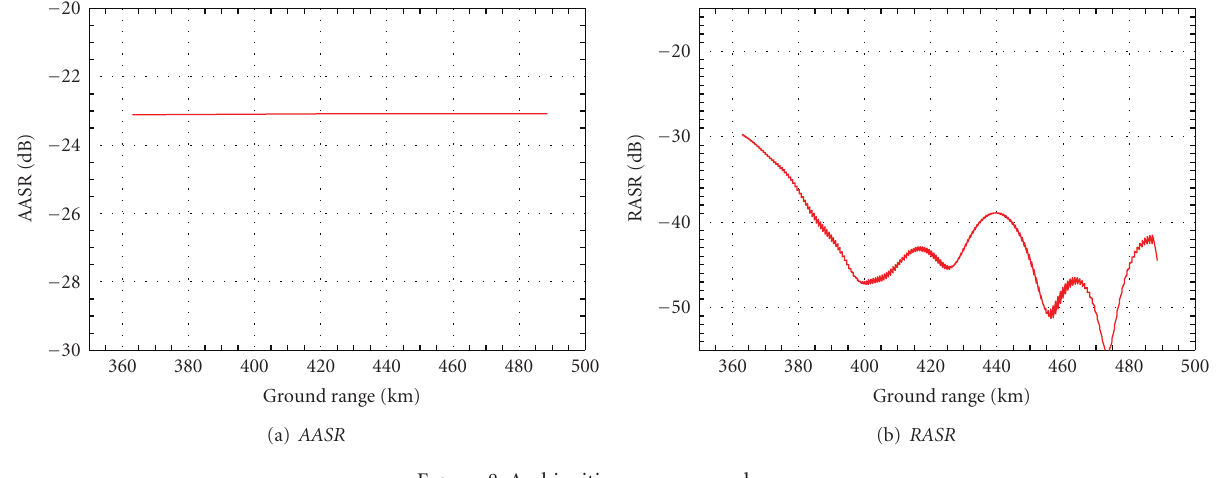
Figure 8: Ambiguities versus ground range.